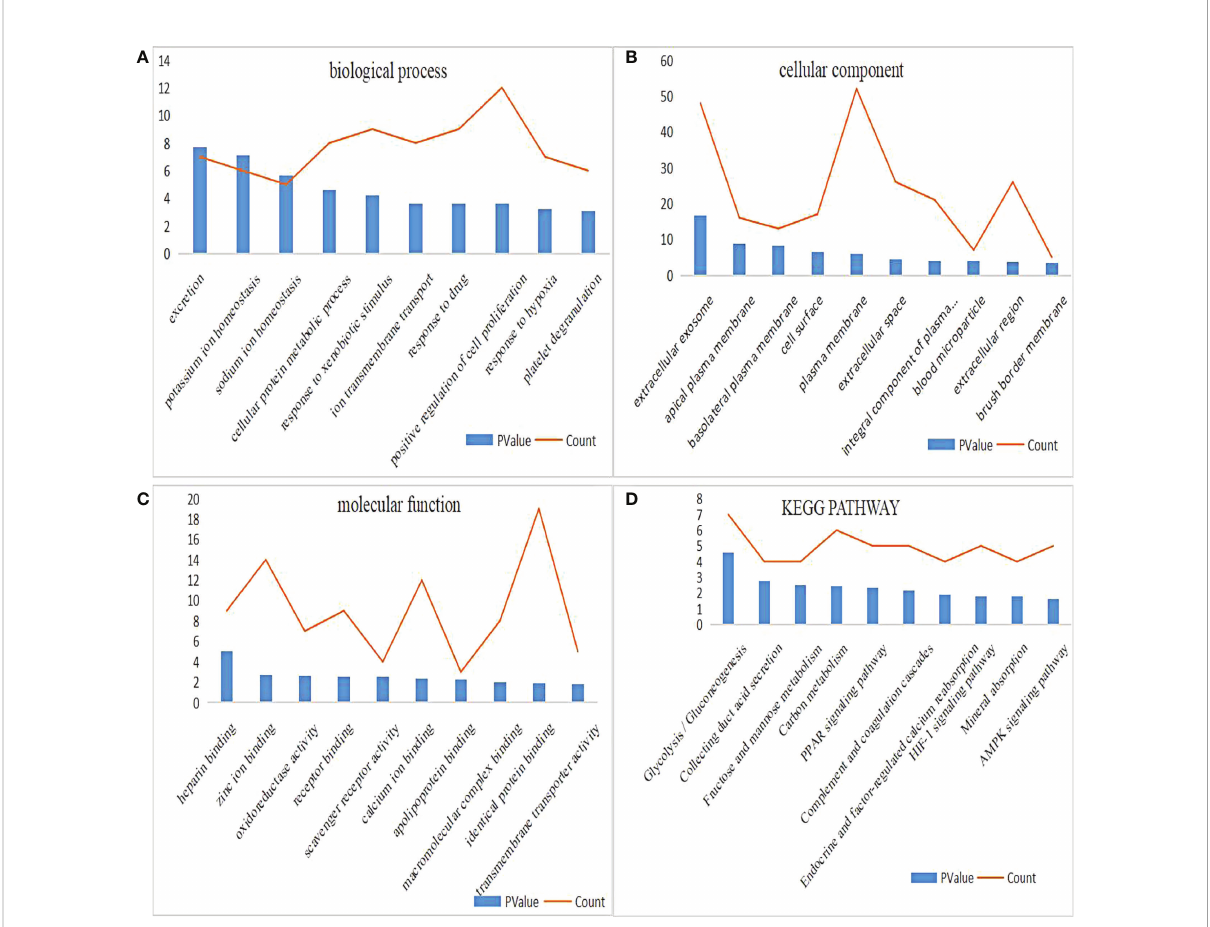
FIGURE 2 GO and KEGG pathway enrichment analysis of DEGs. (A) The biological process enrichment results of DEGs ranked top 10 in P value. (B) The cellular component enrichment results of DEGs ranked top 10 in P value. (C) The molecular function enrichment results of DEGs ranked top 10 in P value. (D) The KEGG pathway enrichment results of DEGs ranked top 10 in P